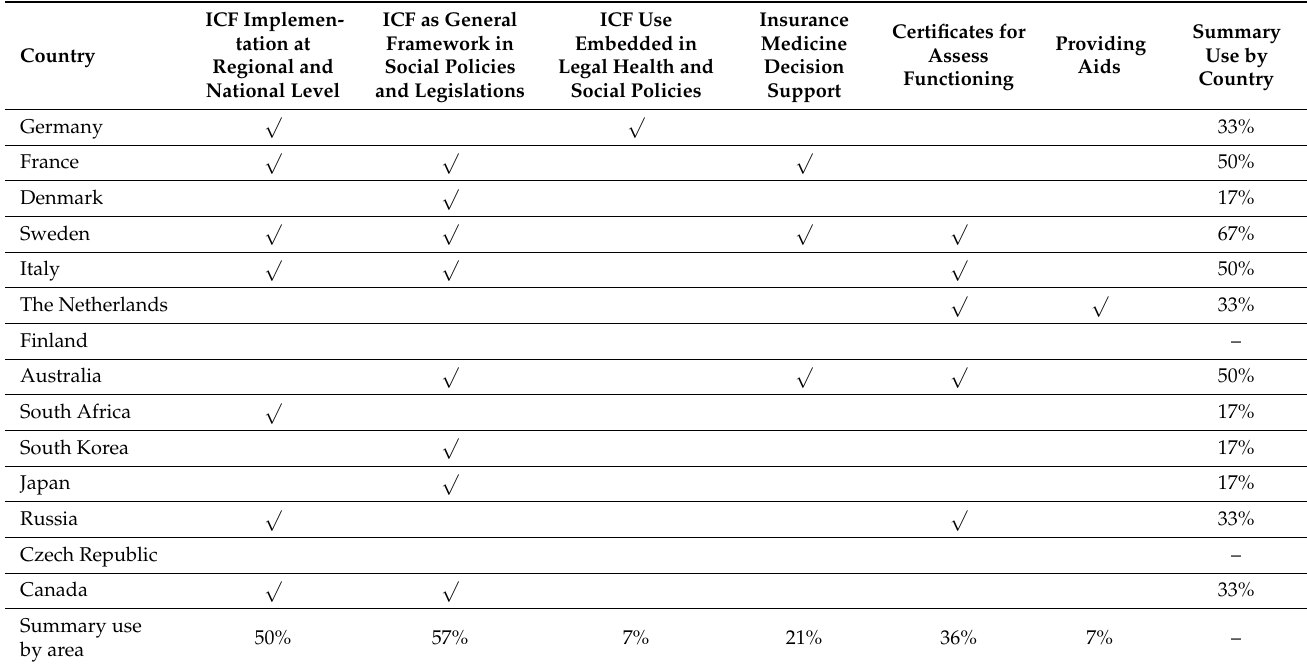
Table 3. ICF uses in national and regional